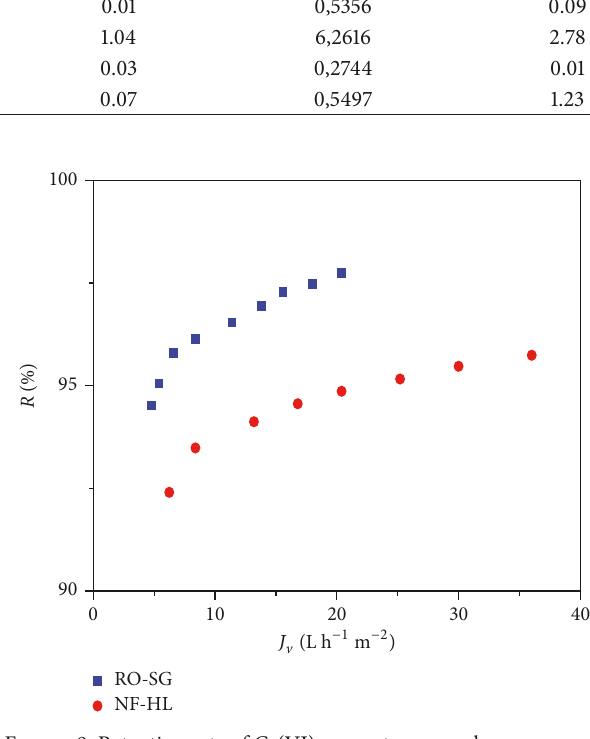
Figure 9: Retention rate of Cr(VI) versus transmembrane pressure for NF-HL and RO-SG membranes, 𝑌 = 50%, pH = 8, and 𝜃 = 25 ∘